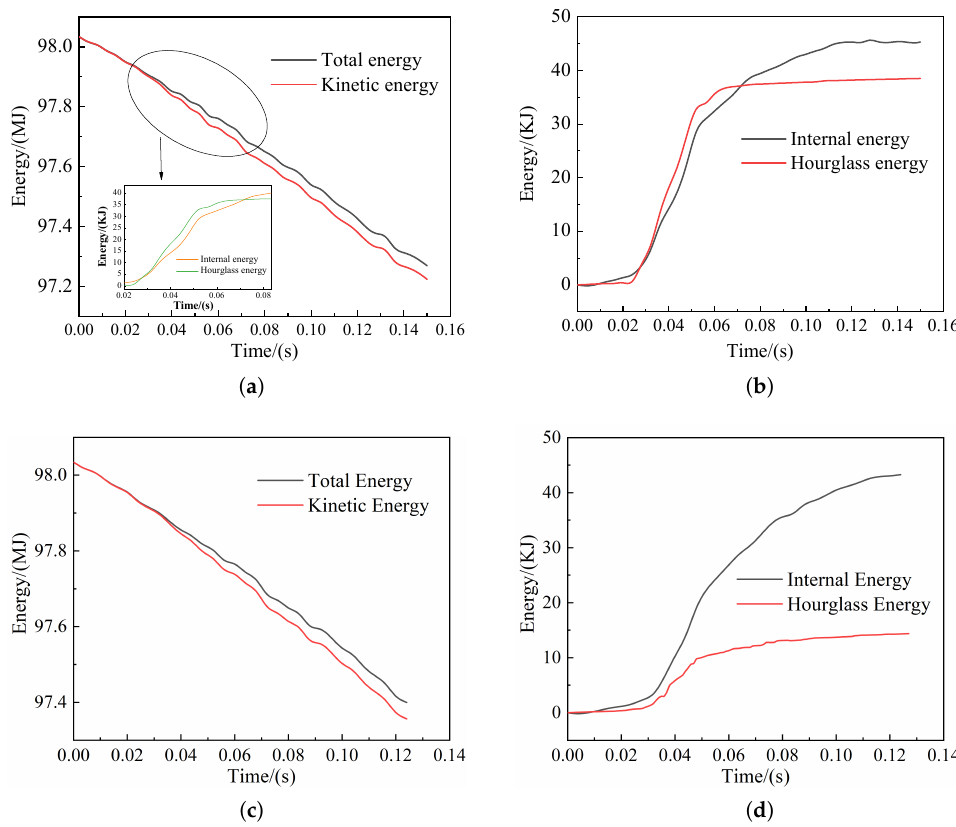
Figure 21. Collision energy curve: ( a ) Total energy and kinetic energy curve of frontal collision of pig; ( b ) internal energy and hourglass energy curve of frontal collision of pig; ( c ) total energy and kinetic energy curve for pig bias collision; ( d ) internal energy and hourglass energy curve for pig bias